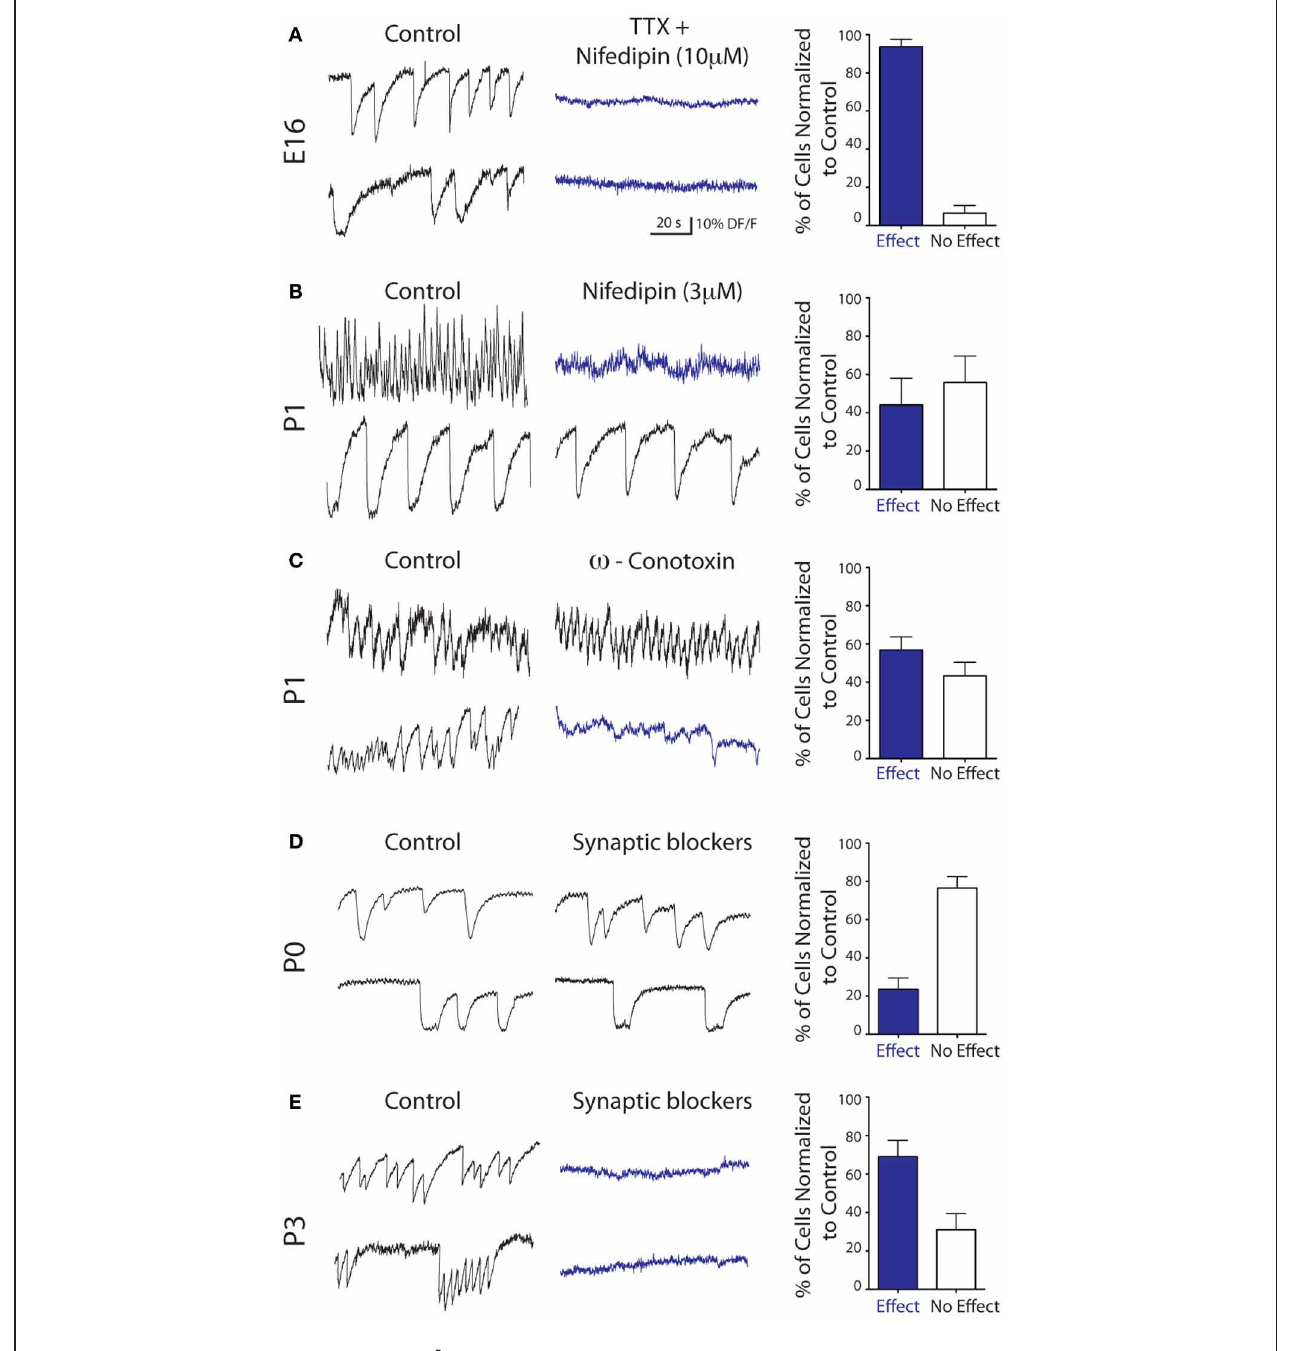
FIGURE 3 | Pharmacology of the spontaneous Ca 2 + activities of embryonic and early postnatal mDA neurons. Representative calcium fluorescence traces from mDA neurons and corresponding quantitative data at the indicated ages showing the effect of TTX